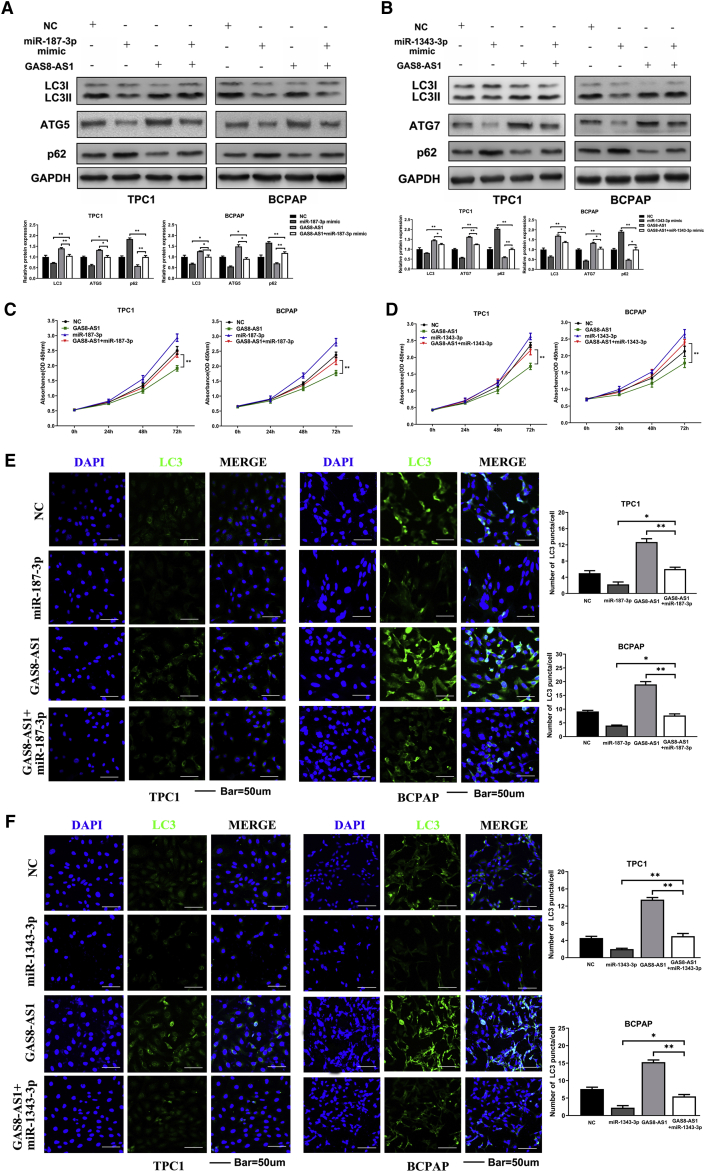
miR-187-3p and miR-1343-3p Overexpression Partly Impaired GAS8-AS1–Induced Inhibition of Malignant Behavior in PTC Cells(A–C) LC3II/LC3I, ATG5, and p62 levels were analyzed using western blotting (A), cell growth was analyzed using CCK-8 assay (B), and LC3 puncta were evaluated using IF (C) in TPC1 and BCPAP cells transfected with NC, miR-187-3p mimic, GAS8-AS1, or co-transfected GAS8-AS1 and miR-187-3p mimic. (D–F) LC3II/LC3I, ATG7, and p62 levels were analyzed using western blotting (D), cell growth was analyzed using CCK-8 (E), and LC3 puncta were evaluated using IF (F) in TPC1 and BCPAP cells transfected with NC, miR-1343-3p mimic, GAS8-AS1, or co-transfected with GAS8-AS1 and miR-1343-3p mimic. Statistical differences were analyzed using the independent samples t test; data are shown as the mean ± standard error of the mean based on three independent experiments. ∗p < 0.05, ∗∗p < 0.01.